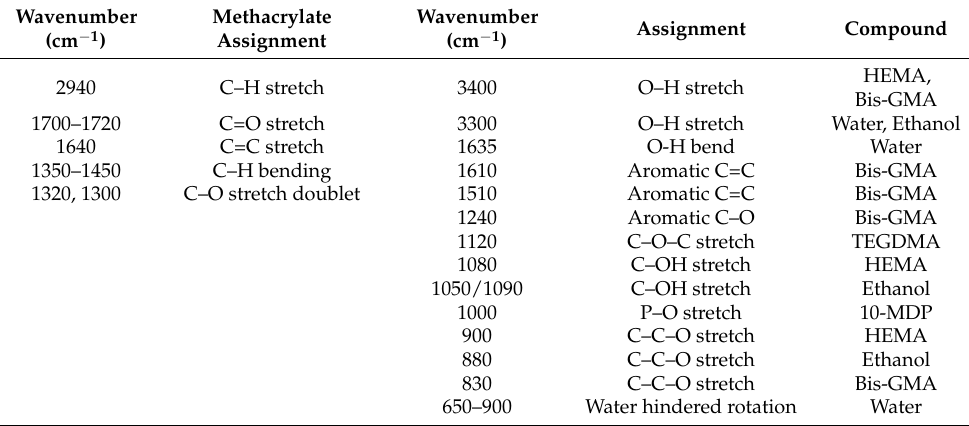
Table 2. IR assignments for common dental monomers and solvents—left side peaks are due to the methacrylate group and right side peaks are due to solvents and groups attached to the methacrylate that may be used to narrow down which methacrylates are